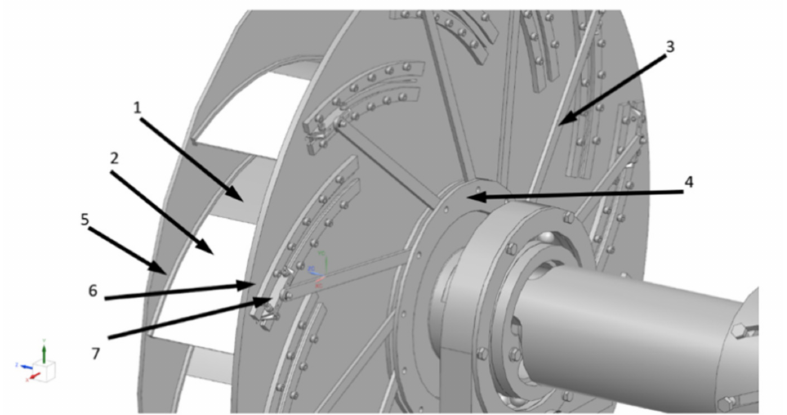
Figure 6. Impeller geometry change mechanism—parts mounted to the impeller.